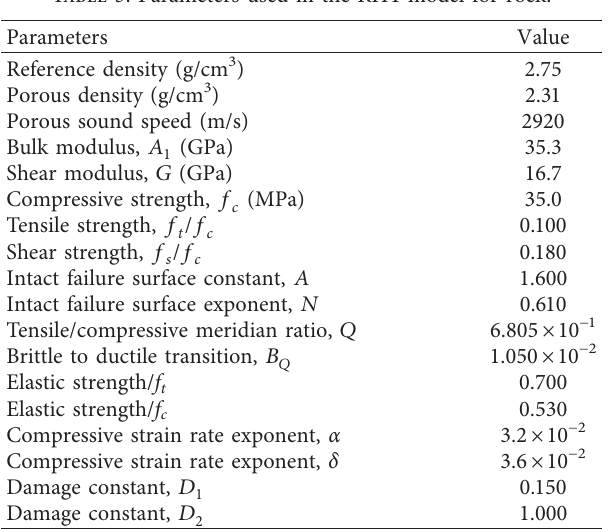
Table 3: Parameters used in the RHT model for rock.